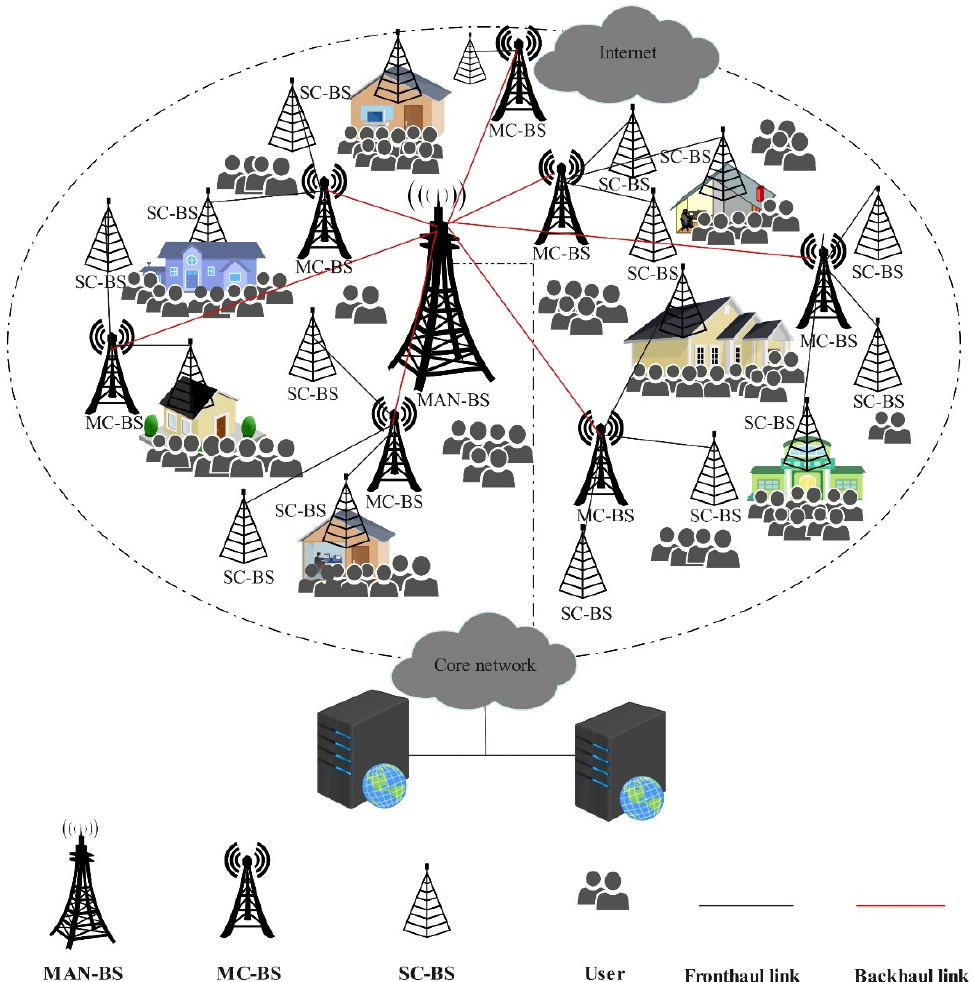
Figure 11. General structure of the proposed B5G UDNs.